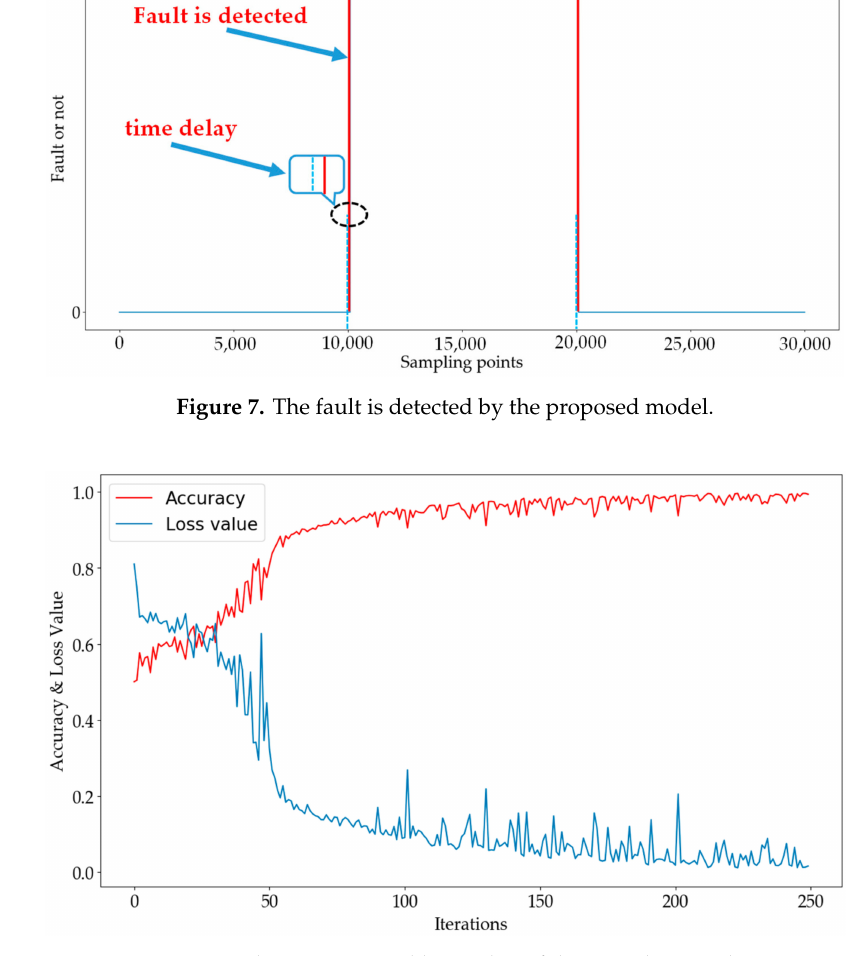
Figure 8. The accuracy and loss value of the neural